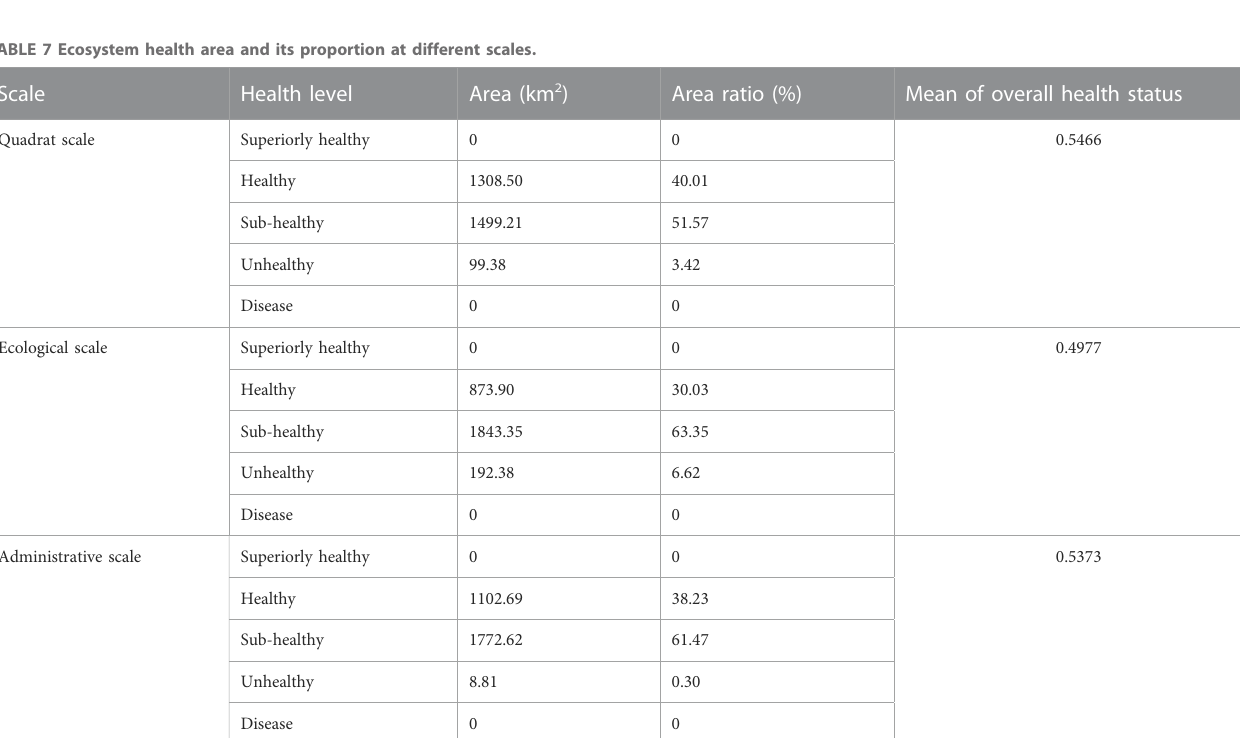
grades, and the overlap area of sub-healthy accounted for the largest proportion (29.61%). 2) For the quadrat scale and ecological scale, there were three overlapping regions of healthy, sub-healthy and